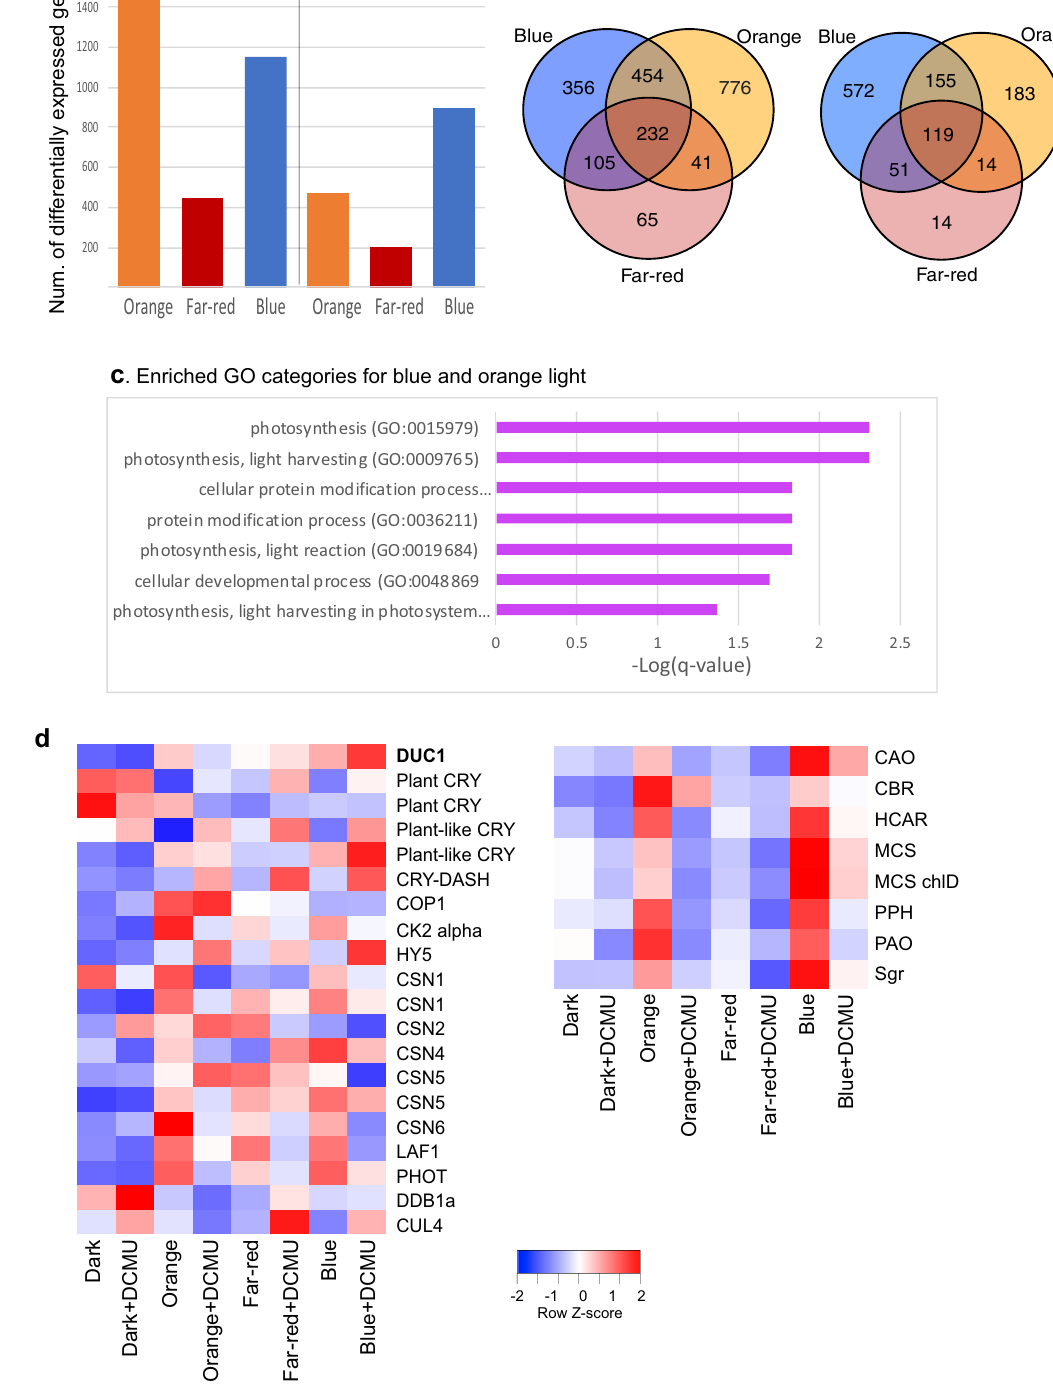
Fig. 5 Transcriptome analysis under monochromatic blue, orange, and far-red light. a Number of DEGs under each monochromatic light (blue, orange, far-red) against dark conditions. Right: samples were treated with DCMU; left: no DCMU treatment. The DEG is de fi ned as >1.5-fold for gene expression with a q -value < 0.05. b Venn-diagram of number of DEGs in Fig. 5a. c GO enrichment analysis for 686 co-regulated DEGs under blue and orange light. d Expression values for DUC1 and light-signaling genes. The source data underlying Fig. 5b, d are provided as a Source Data fi